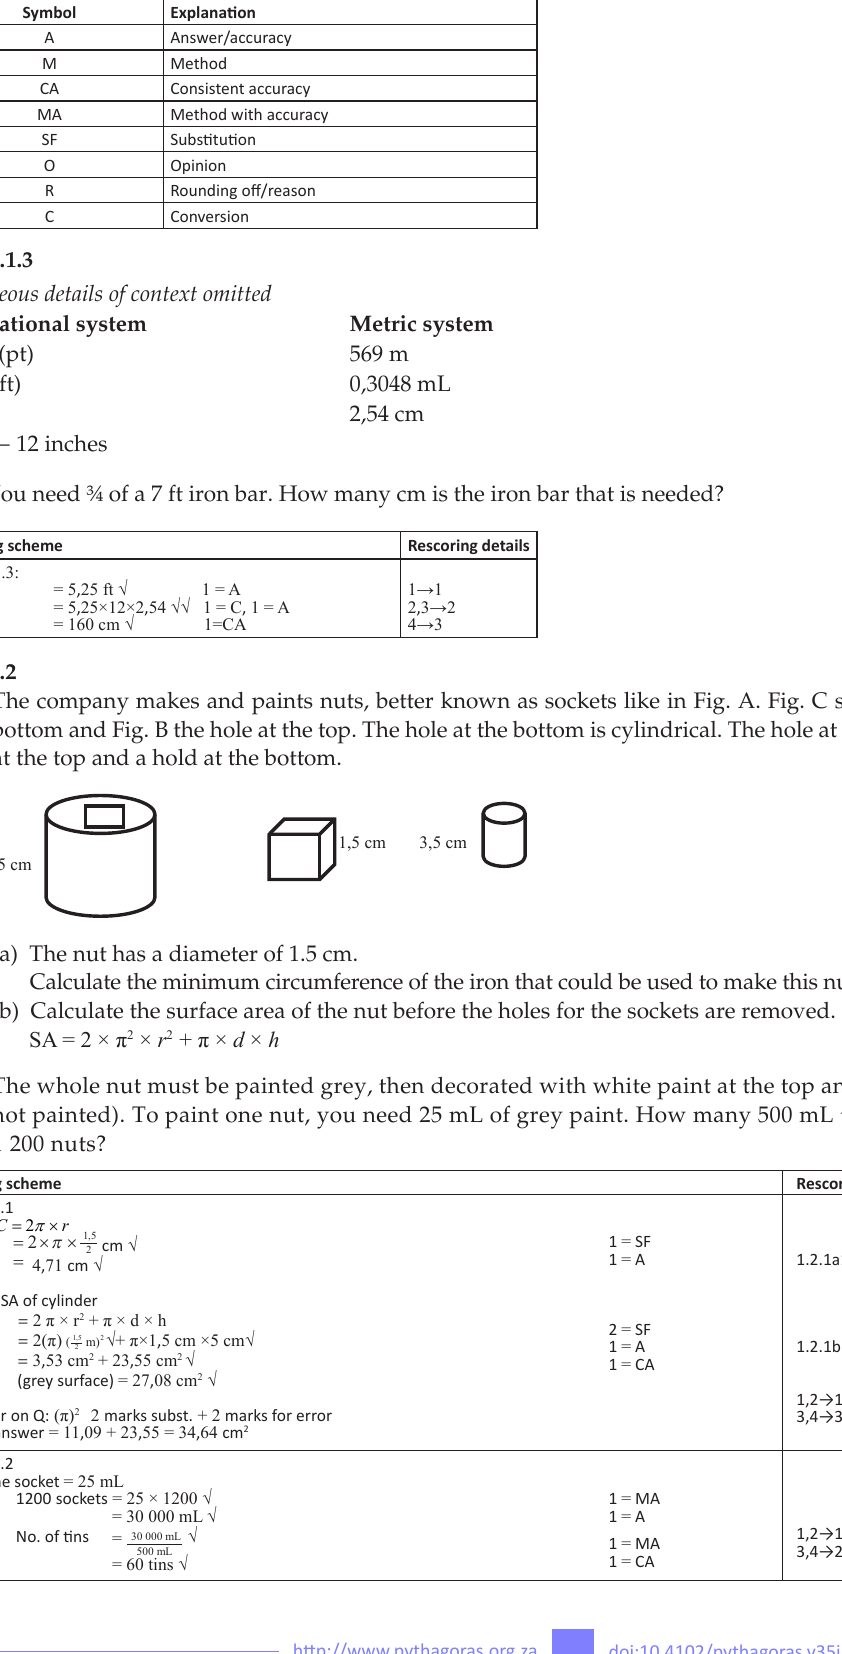
TABLE 1: Explanation of symbols in the marking guide. Symbol